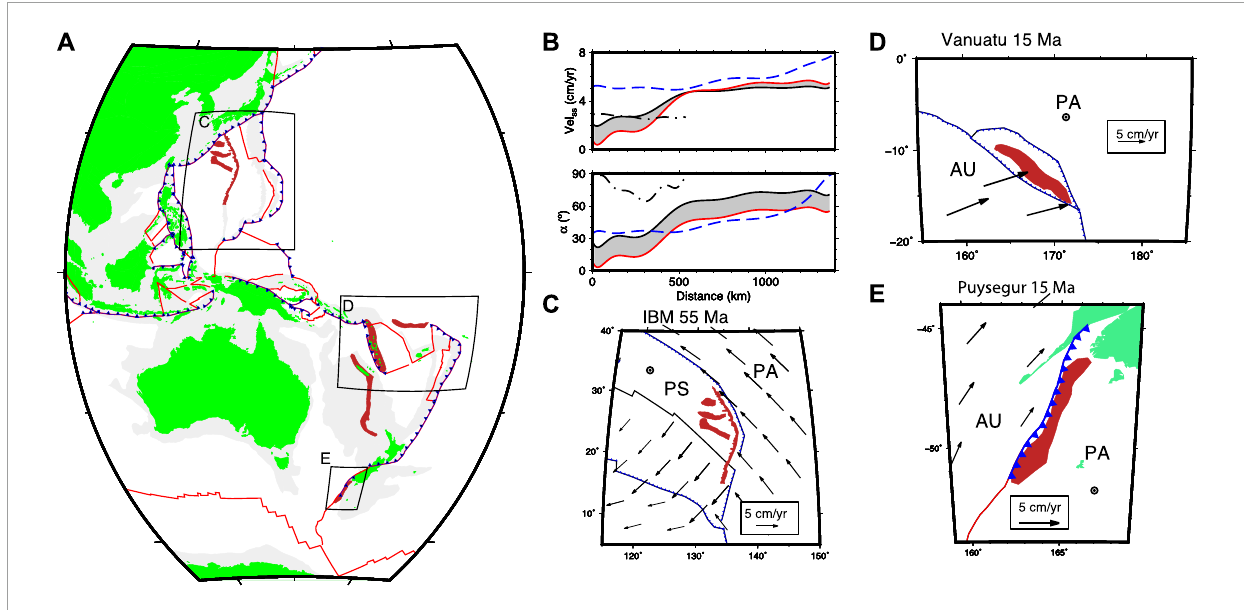
FIGURE 1 Three Cenozoic subduction initiation events that occurred in the western Pacific showing a substantial component of relative, strike-slip motions at the nascent trench just prior to initiation. (A) . Present-day western Pacific with the structures against which subduction initiated shown in brown. Regions of detail shown with boxes. (B) . Magnitude of strike slip motion (above) and convergence direction (below, with 0 being normal to the strike of the trench) before onset of initiation. Izu-Bonin-Mariana (IBM) shown at 55 Ma (red) and 50 Ma (black solid) with values for intermediate times shown with grey shading, Vanuatu at 15 Ma (blue dashed) and Puysegur (black, dot-dashed) using the plate model of Müller et al. (2019). (C) . Conditions at IBM at 55 Ma, 5 Myr before the onset of SI. (D) . Vanuatu at 15 Ma, 1–3 Myr before onset. (E) . Puysegur at 15 Ma, 1–3 Myr before onset. Abbreviations for plates: PA, Pacific Plate; AU, Australia Plate; PS, Philippine Sea